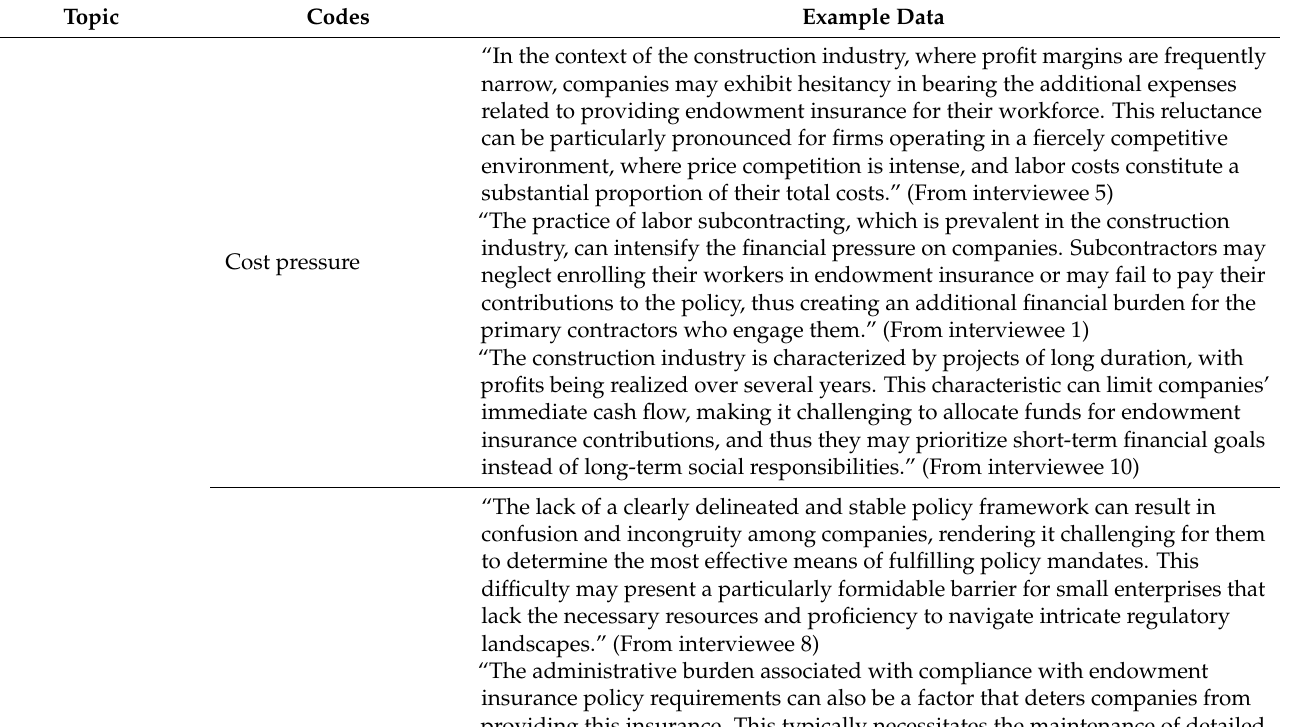
Table 3. Thematic analysis process of